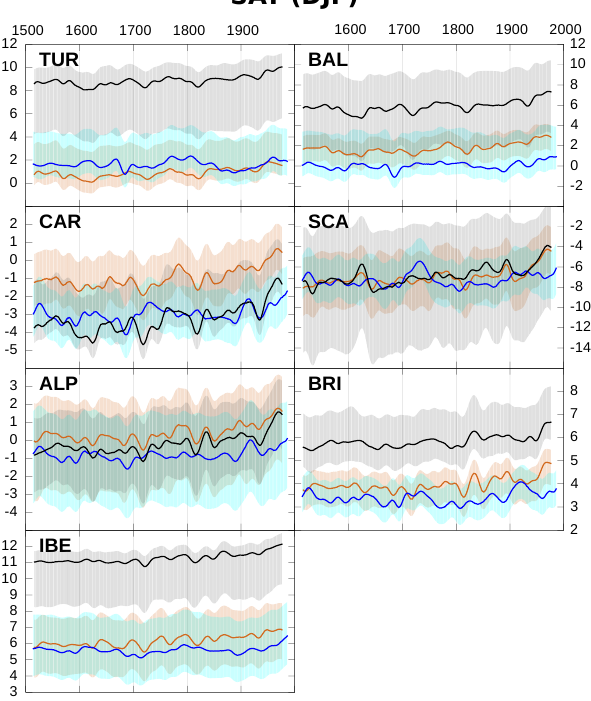
Figure 2. Temporal series of winter SAT in the seven areas indi- cated in Fig. 1 that exhibit added value in the MM5-ECHO-G sim- ulation compared to the GCM alone, according to Gómez-Navarro et al. (2013). The series corresponding to the three different data sets are shown with different colours: driving GCM (i.e. ECHO- G model alone) – black; RCM (i.e. MM5-ECHO-G) – orange; and gridded reconstruction (i.e. the Luterbacher et al. (2004) reconstruc- tion) – blue. Bold lines correspond to the median, whereas the light shading indicates the 25–75 interquartile range to illustrate hetero- geneities within each region. After the calculation of the annual val- ues, the series are smoothed through a Hamming window of 31 time steps to emphasise the low-frequency variability. Note the different scale in different